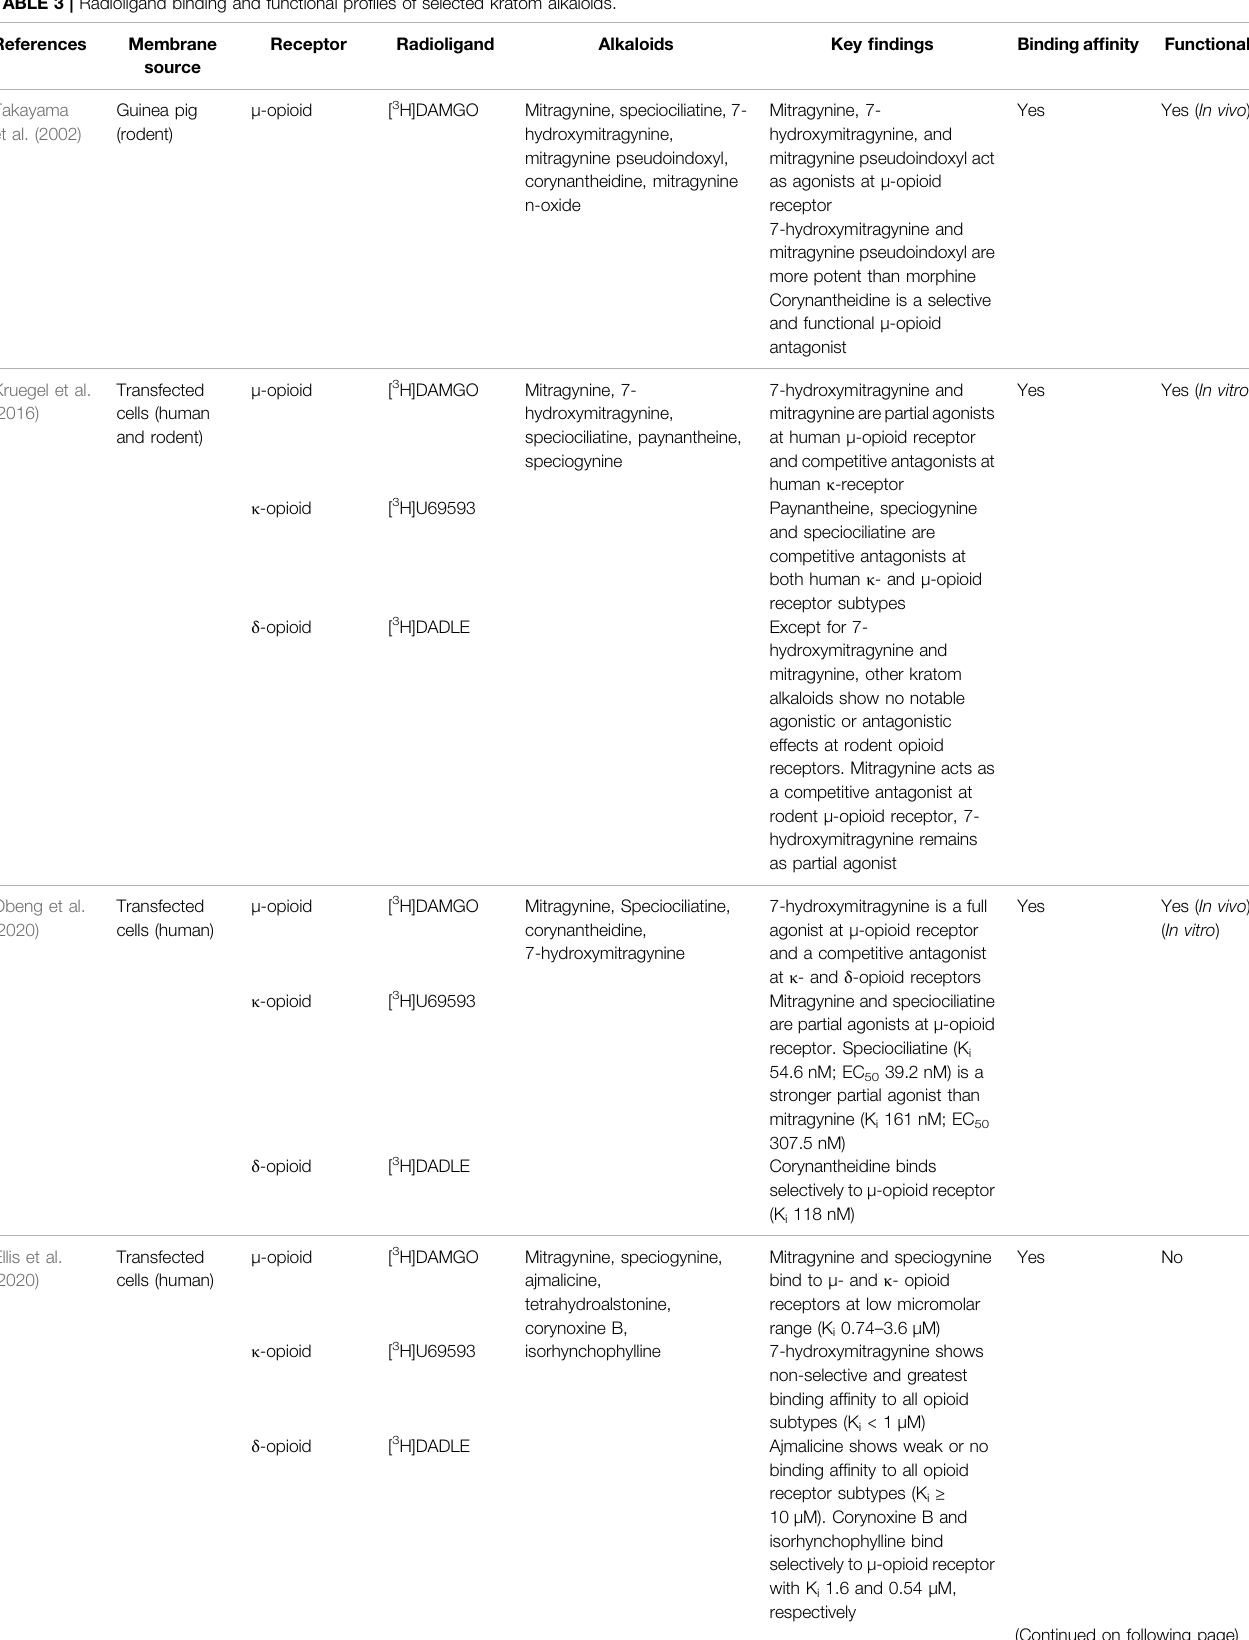
TABLE 3 | Radioligand binding and functional pro fi les of selected kratom